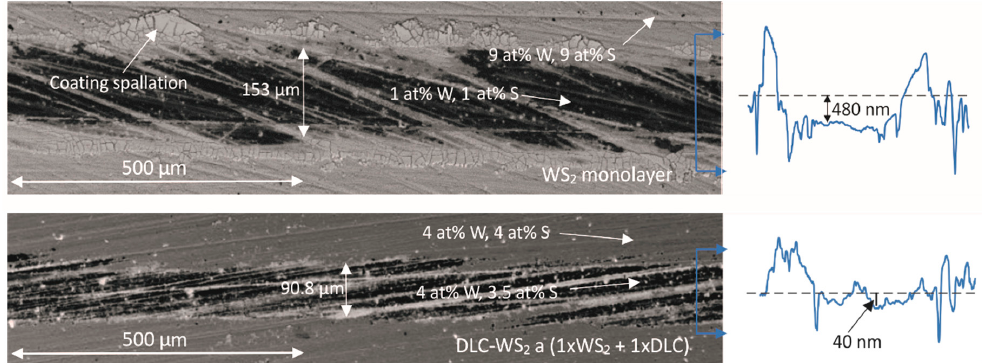
Figure 5 Figure 5. SEM image and profile of the scratches after 100 cycles of the wear test under constant 5 N